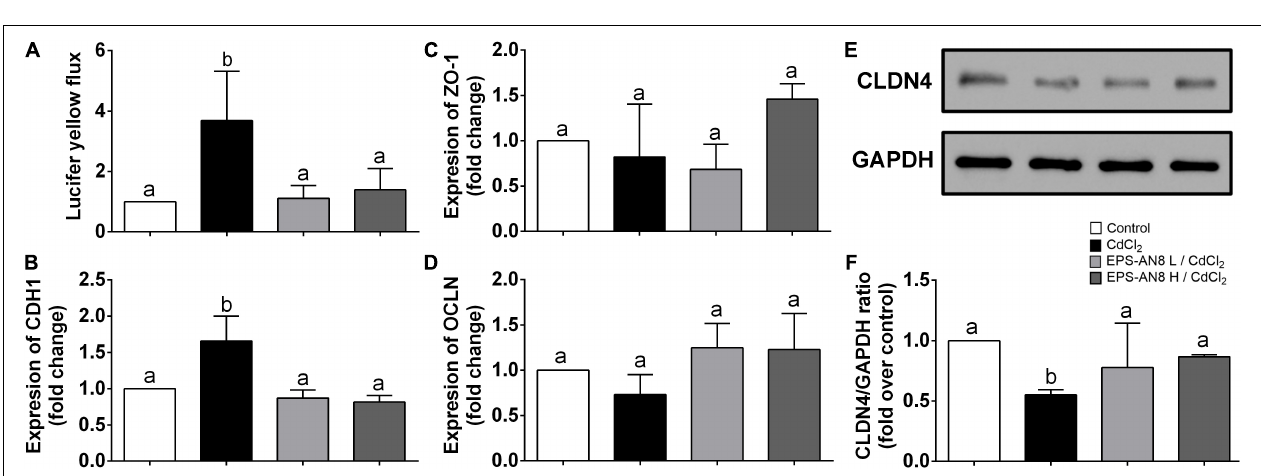
FIGURE 3 | Protection from Cd-induced inflammation. (A) Percentage (%) of cytotoxicity measured in differentiated Caco-2 cells treated with different concentrations (50, 100, and 200 µ M) of CdCl 2 . (B) Effect of Cd and cotreatment with Cd and EPS-AN8 in lower and higher concentrations (L and H) on IL-8 mRNA expression after 3 h. (C,D) P65 protein levels after 24 h of incubation and Western blot and densitometric analysis, respectively. Values that do not share a common letter are significantly ( p < 0.05) different.